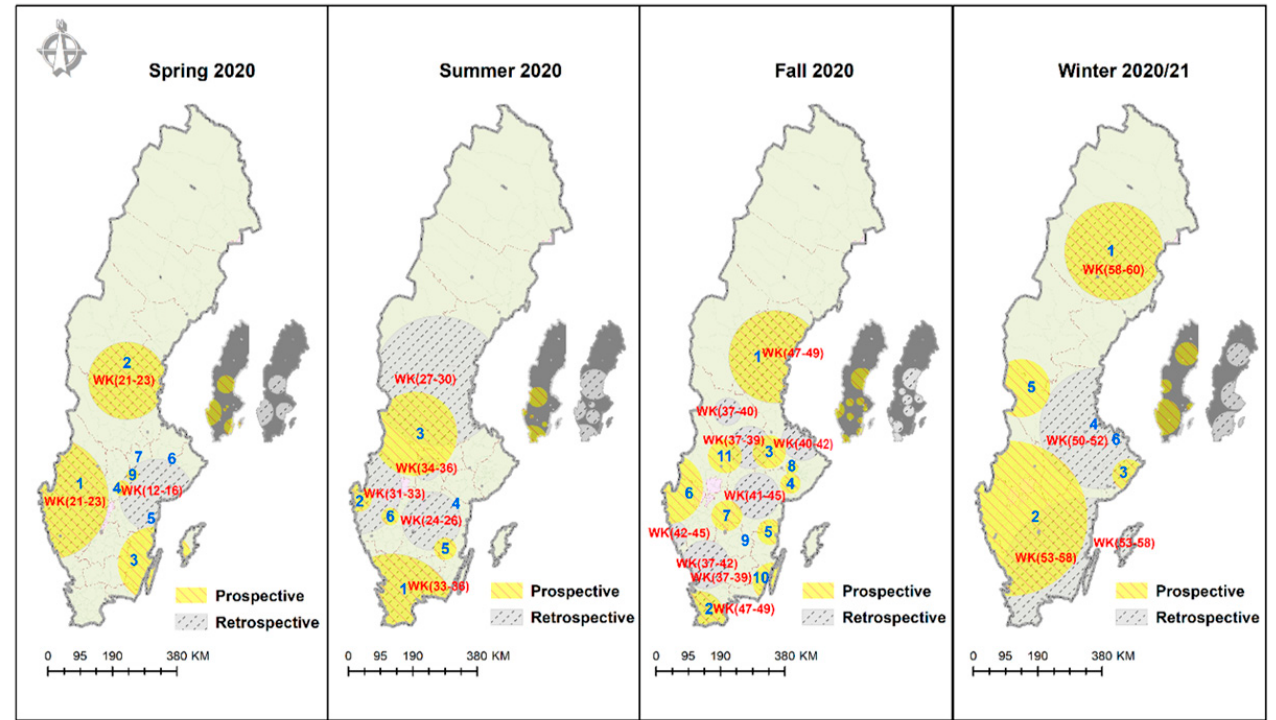
Figure 3. Retrospective and prospective space–time clusters through the seasons.